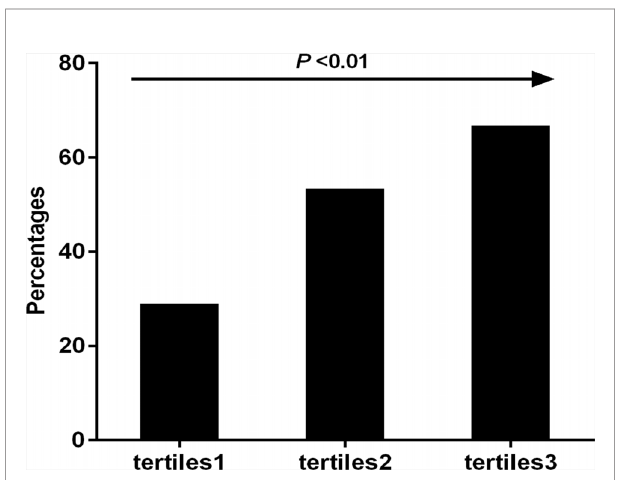
FIGURE 1 | The incidence of NSCLC compared across the tertiles of the TyG index.